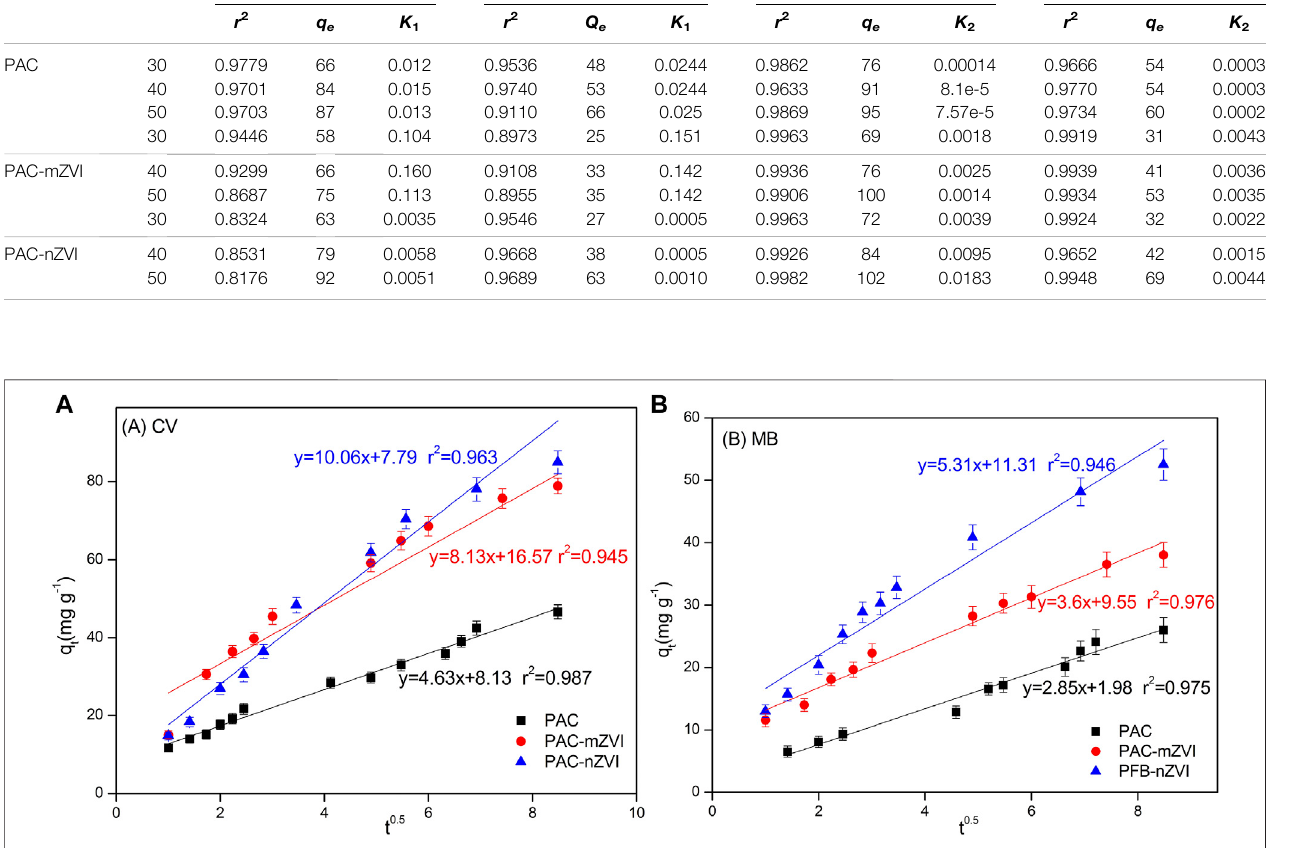
FIGURE 7 | Intraparticle model for the adsorption for the adsorption of CV and MB onto PAC, PAC-mZVI, and PAC-nZVI adsorbents.